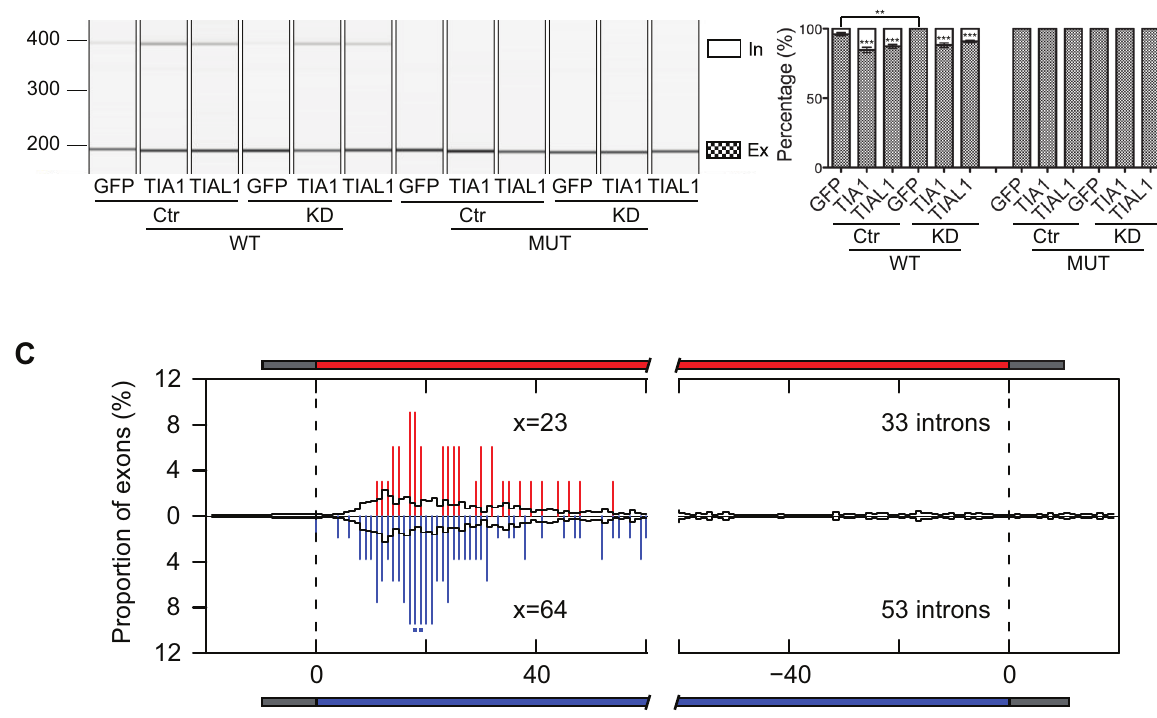
Figure 4. RNA maps of TIA-regulated cassette exons and introns. RNA map showing the percentage of alternative cassette exons (A) or retained introns (C) with clustered TIA1/TIAL1 crosslink sites at exon/intron boundaries, including 20 nt of exonic and 60 nt of intronic sequence. The number of crosslink events at each region ‘‘x’’ 10–28 nt downstream of exon/intron boundaries and the total number of exons analysed are shown for silenced ( D Irank # 1, blue bars), enhanced ( D Irank $ 1, red bars), and control exons (| D Irank| # 0.1, black line). The positions with a significantly higher number of crosslinking events in TIA-regulated RNAs than in control are indicated by red or blue dots above bars (* p , 0.05, Fisher’s Exact Test). (B) Minigene validation of enhanced alternative cassette exon from OGT1 pre-mRNA. The schematic diagram of each isoforms is shown, and the TIA binding sites are zoomed in above, with crosslinking nucleotides in red. The mutated sequences are shown below. Capillary electrophoresis image and signal quantification are shown below. Quantified transcripts including (in) or excluding (ex) the regulated alternative exon are marked on the right. Average quantification values of exon inclusion (white) and exclusion (grey) are given as a fraction of summed values. Error bars represent standard deviation of three replicates and p values are also calculated for TIA1 and TIAL1 overexpression compared to GFP transfected cells in either control or KD situation (** p , 0.01, *** p , 0.001, one-way ANOVA).